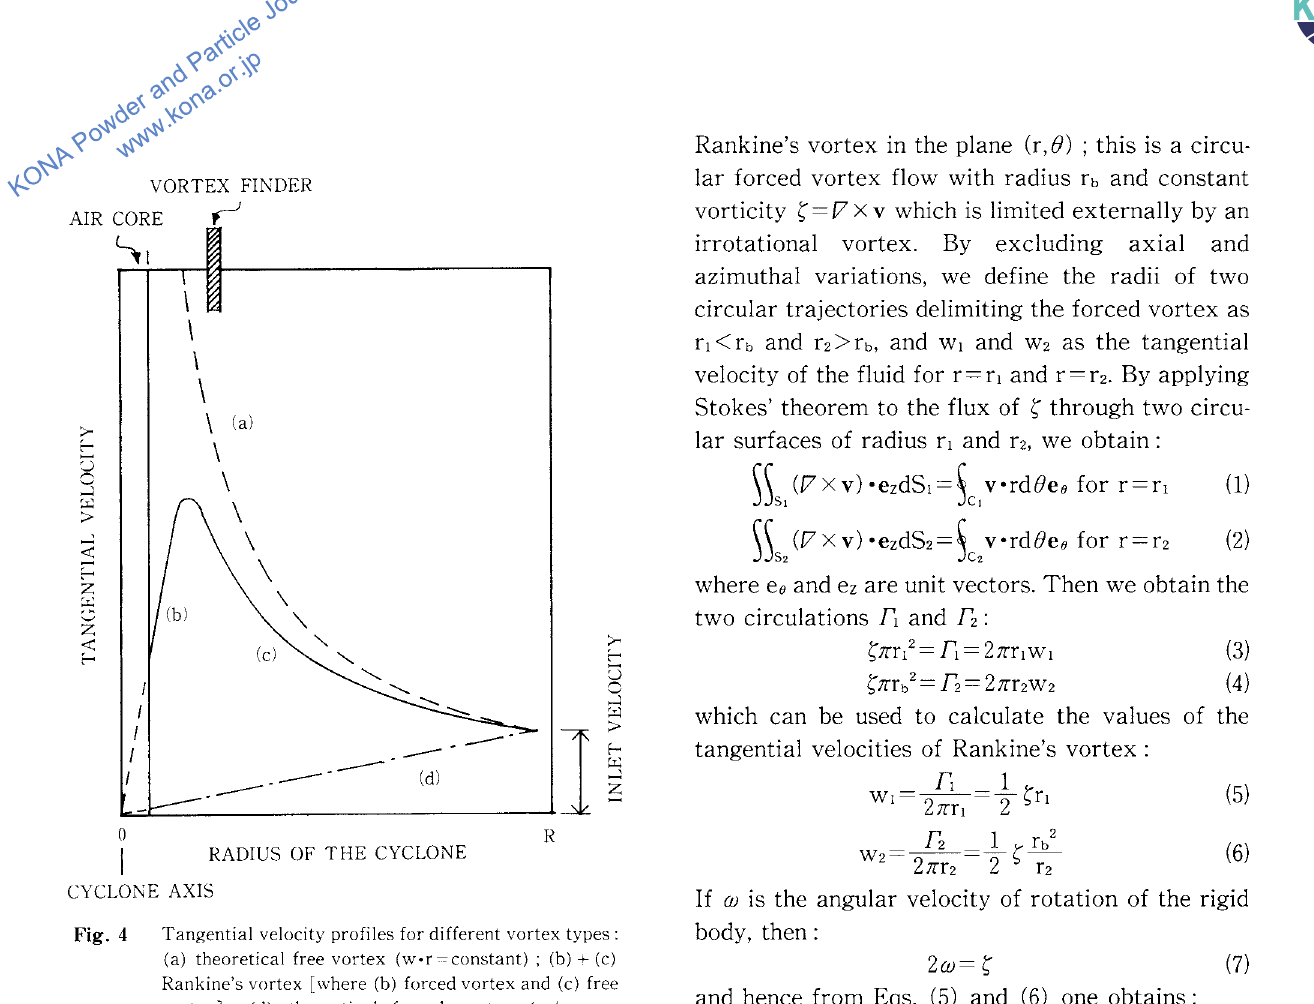
Tangential velocity profiles for different vortex types: (a) theoretical free vortex (w·r~constant); (b)+ (c) Rankine's vortex [where (b) forced vortex and (c) free vortex]; (d) theoretical forced vortex (w/r=con stant). vertical axis of the vessel and a radius close to the radius of the vortex finder (a zone where the radial component of the velocity is virtually zero), and a